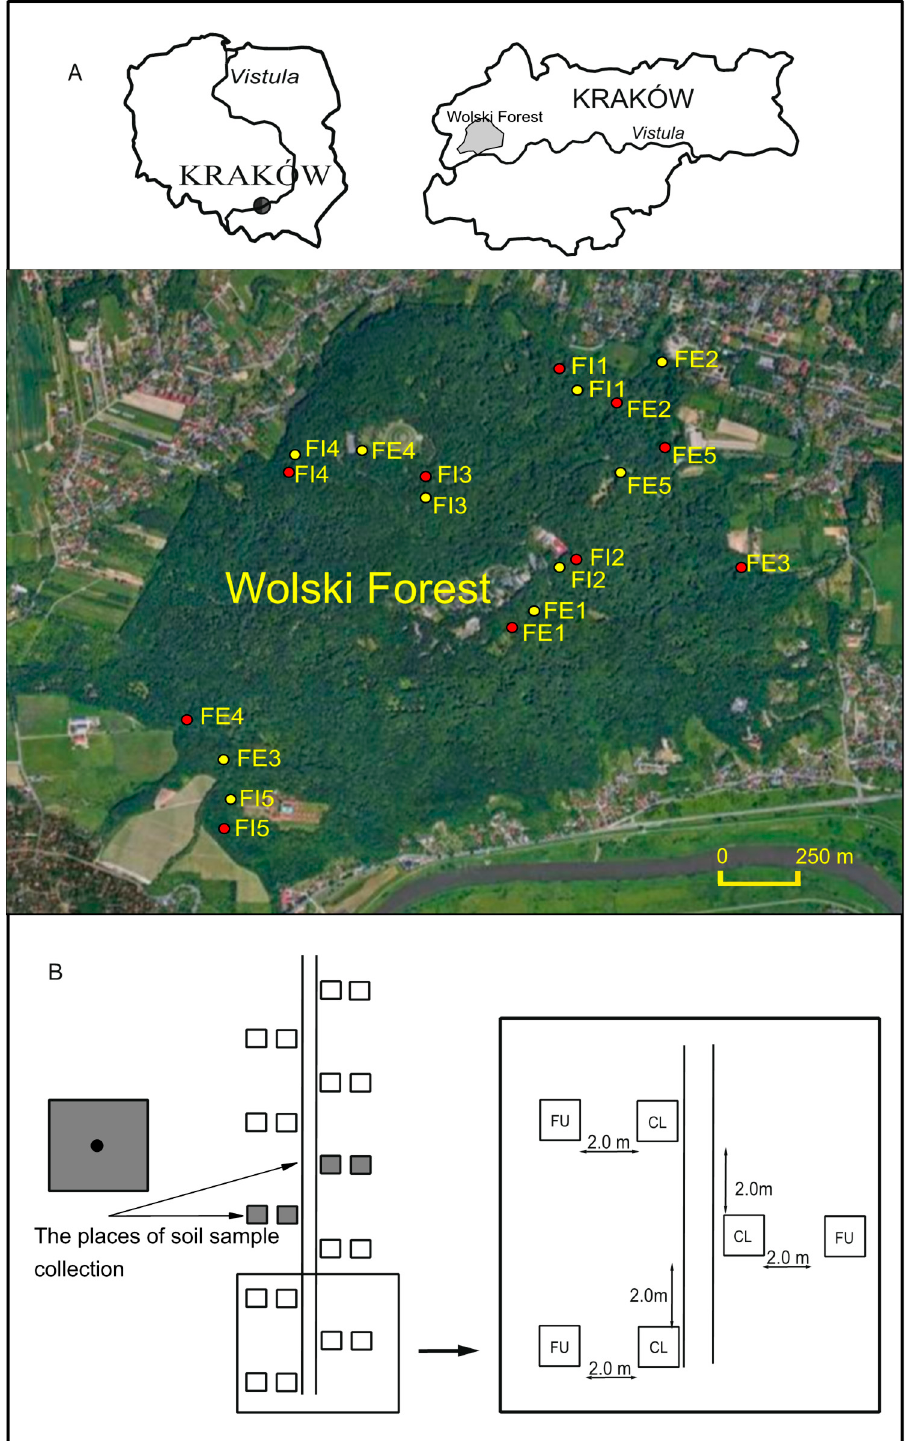
Figure 1. Location of the study sites ( A ) and the sampling design ( B ). Abbreviations of study sites are explained in Table 1; yellow circles mean formal trails, red circles mean informal trails; CL indicates the plot located near the trail, FU indicates the plot located far from the trail.